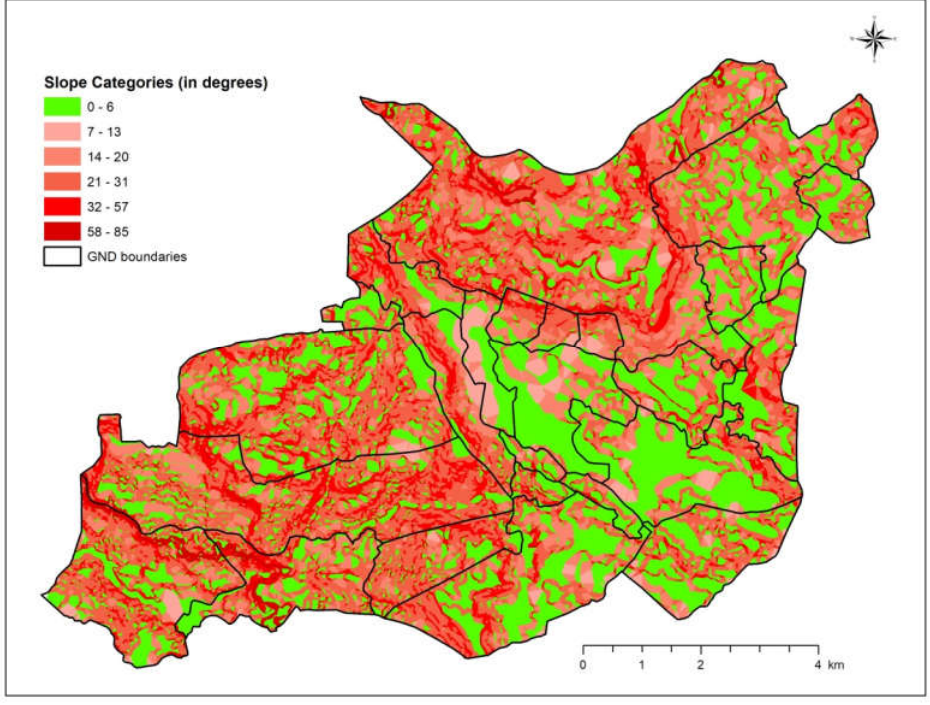
Figure 3. Slope distribution of the study area.